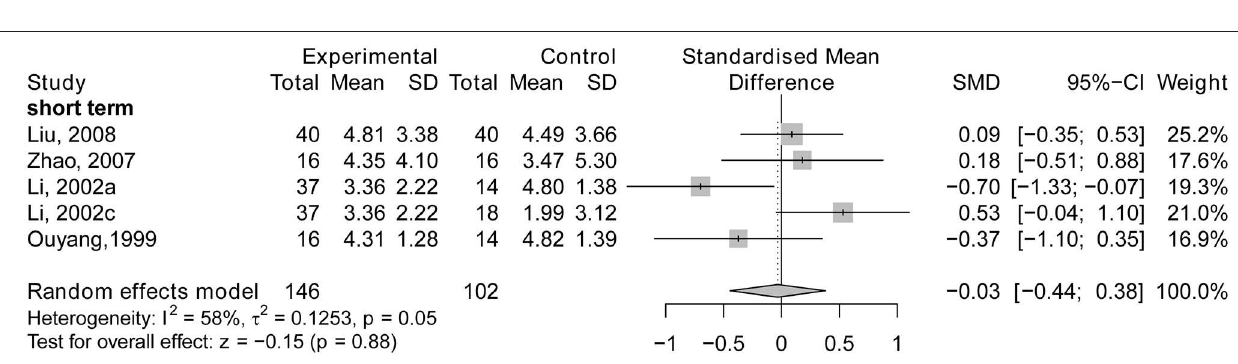
FIGURE 9 | The forest plot of HDS of acupuncture vs. drug therapy. Li (2002a), acupuncture vs. Nimodipine; Li (2002c), acupuncture vs. Dangguishaoyaosan.